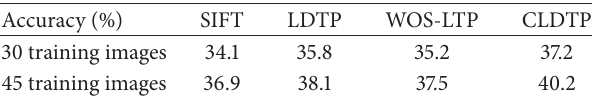
Table 2: Object recognition results on the Caltech-256